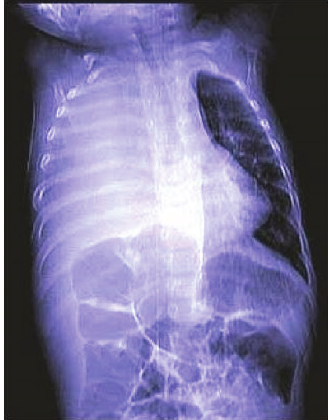
Figure 1: A preoperative PA radiograph.